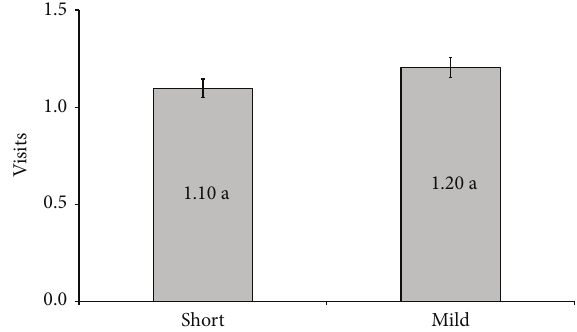
Figure 1: Number of visits to service for monitoring the follicular growth. Means followed by the same letter do not differ significantly through the 𝑡 -test at a 5%